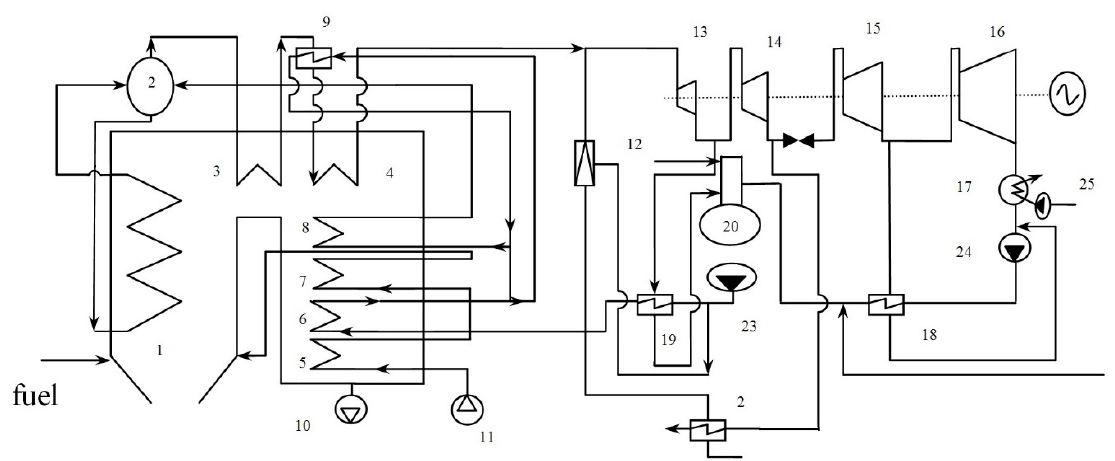
Figure 3. Technological scheme of a steam-turbine mini thermal power plant.